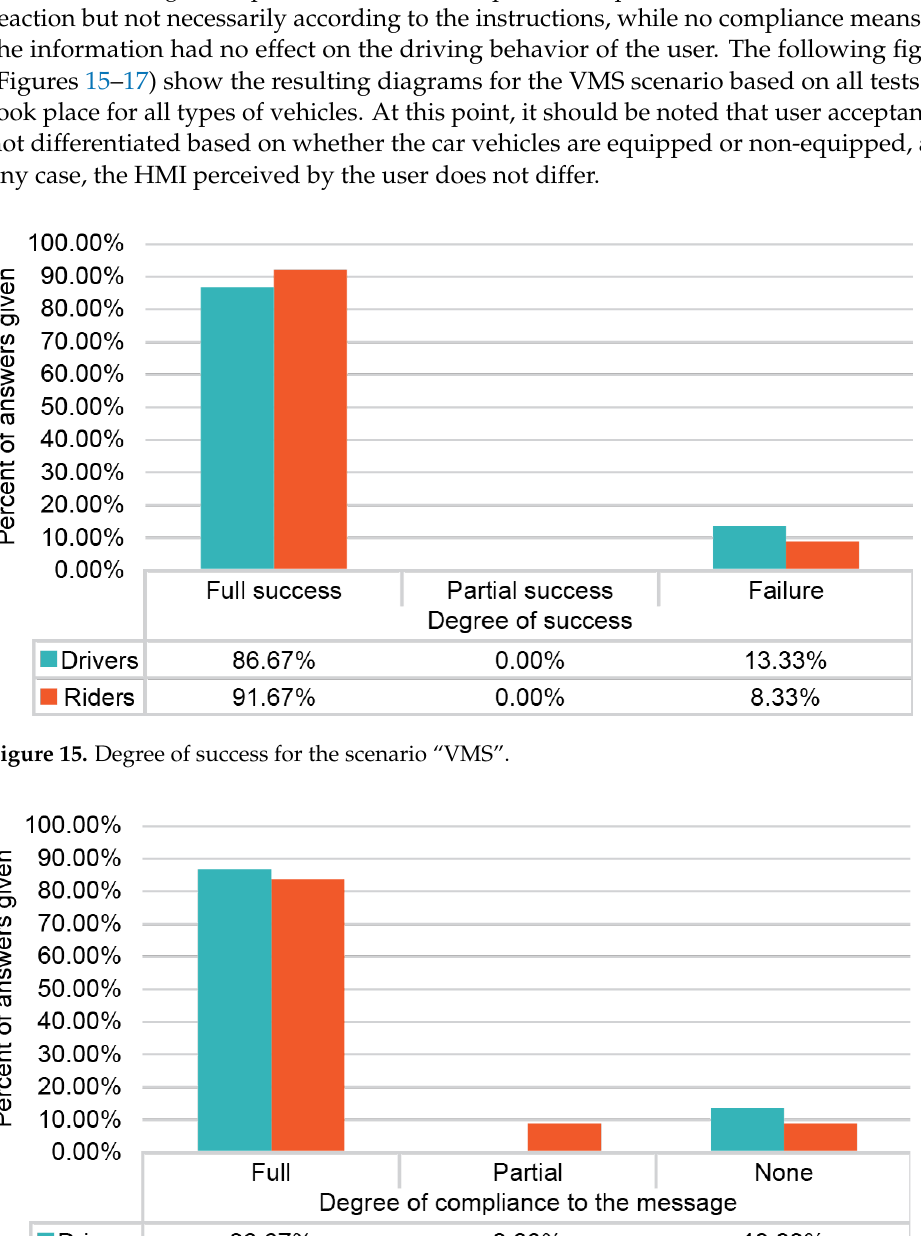
Figure 17. Recorded reactions for the scenario “ VMS ” . Regarding compliance, the sum of the results indicated that for the drivers, the suc- cess rates were close to 90% for all scenarios, while for the riders this number was close to 80%. Partial success was rare and ranged between 0% for some scenarios and up to 10% for others, while the full failure of the trial was constantly close to 10% with the riders showing slightly higher percentages by 2% compared to drivers. The second dimension of user acceptance is derived from the analysis of the provided questionnaires. From these questionnaires, it was possible to draw conclusions about the profile of the users and their opinion regarding the experience with the system. 5.2.1. Results Derived from the Pre-Test Questionnaires The gender representation amounted to 64.71% for men and 35.29% for women, how- ever, the extracted results refer to all users and were not distinguished based on gender. A total of 33.33% of users have driving experience of up to ten (10) years, 40% have from 11 – 20 years and 26.67% have 21 – 30 years. Out of these, it is noteworthy that only 18.75% drive a car that is less than five (5) years old in their daily commutes, with the majority driving older generation vehicles. Most of these drivers (88.24%) indicate that they use their vehicles on a daily basis. Exceeding the speed limit and illegal parking are the most